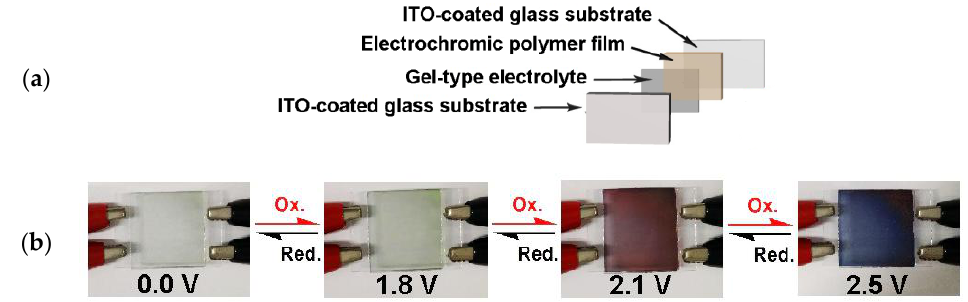
Figure 13. ( a ) Schematic illustration of the structure of the electrochromic devices. ( b ) Photos of the sandwich-type ITO-coated glass electrochromic device using P1 film as active layer at indicated applied voltages. Figure 12. Percentage transmittance changes of the cast films of P2 on the ITO-glass slide (coated area ~1 cm 2 ) (in CH 2 Cl 2 with 0.1 M Bu 4 NClO 4 as the supporting electrolyte) by applying a potential at ( a ) 0.0 ↹ 0.8 V and ( b ) 0.0 ↹ 1.39 V for 20 cycles.